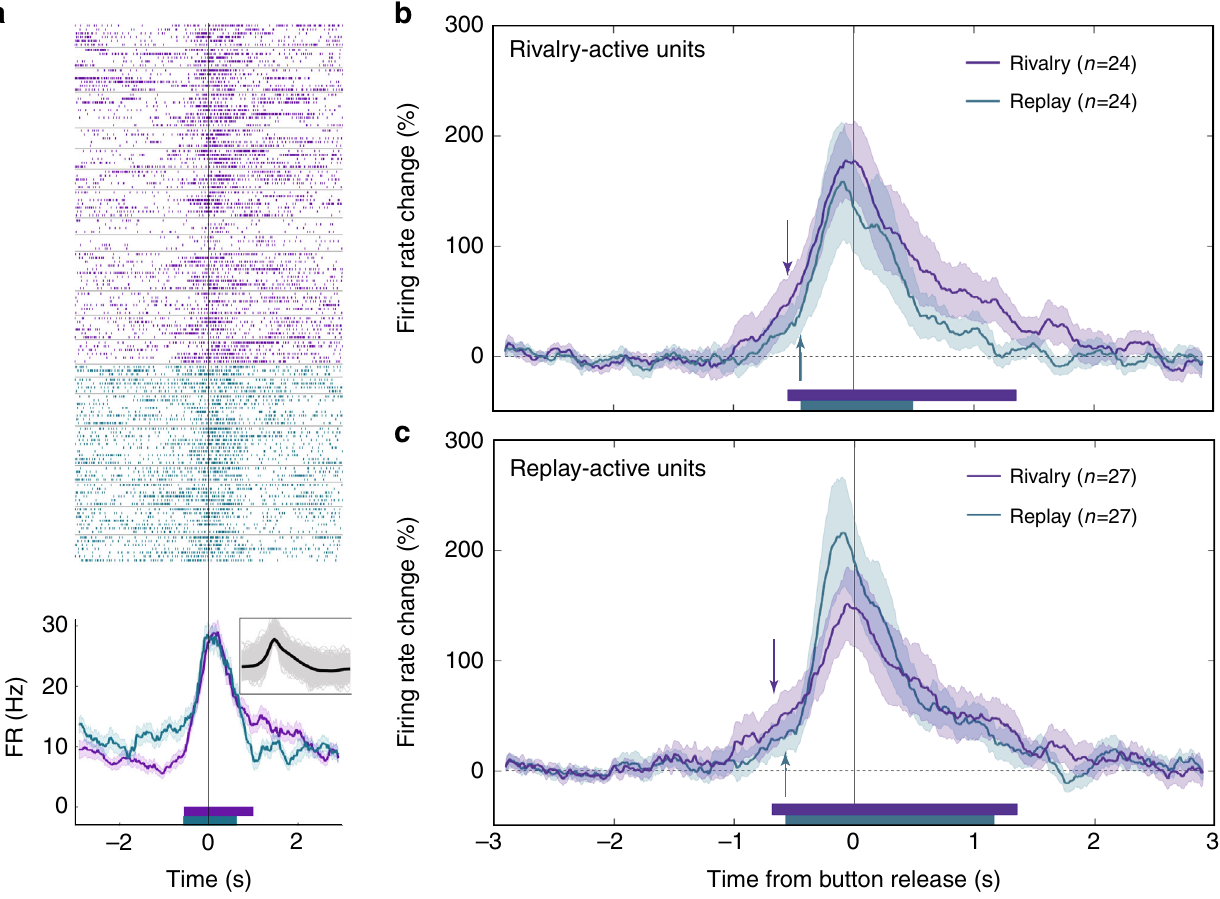
Fig. 6 SMA activity during rivalry and replay. Convention as in Fig. 5. a Firing of an SMA multi-unit around the report of a perceptual transition onset during rivalry (purple) and replay (cyan). Note that this anticipatory activity was nonselective and accompanied the transition to any image. Average FR percent change across all rivalry-active units ( b ) and replay-active units ( c ). Note that here activity onset during rivalry and replay is highly